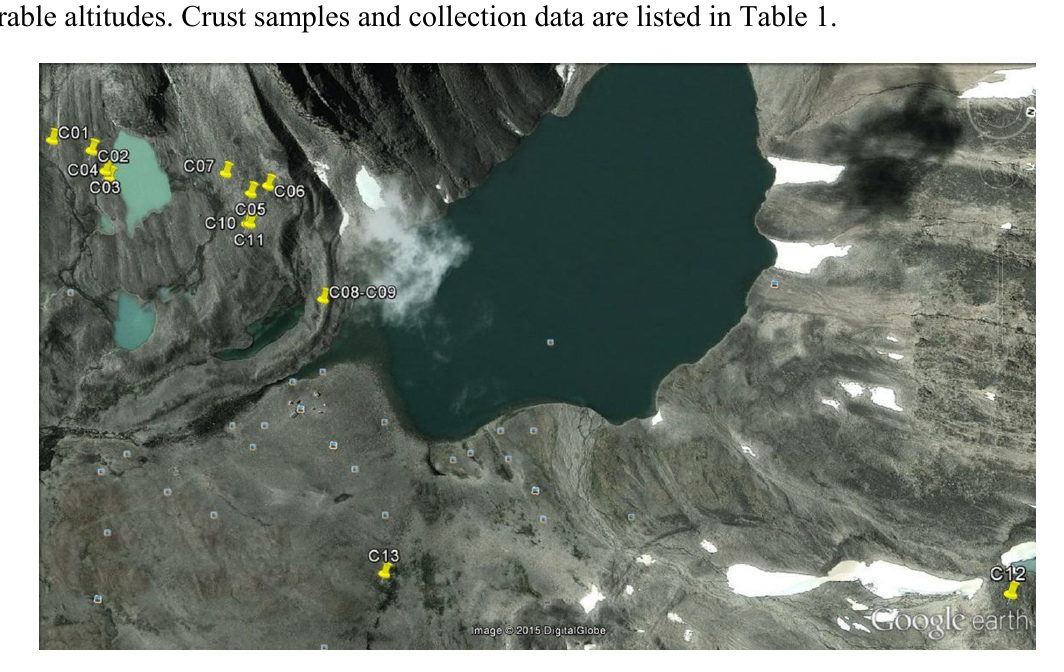
Figure 2. Map of the study area showing the location of the sampling